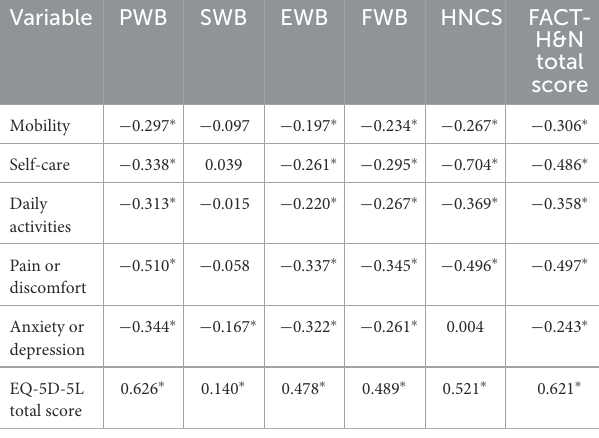
TABLE 2 Correlation coefficient between EQ-5D-5L and FACT-H&N scale scores.